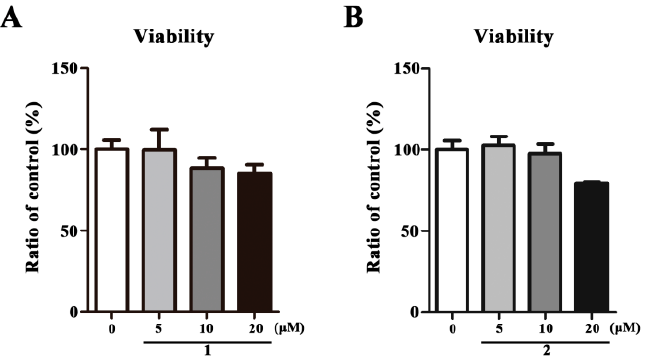
Figure 3. The effect of 1 and 2 on cell viability in HepG2 cells. HepG2 cells were treated with the indicated concentrations of 1 or 2 for 48 h followed by MTT assay. All the data are expressed as mean ± SEM ( n = 3) and analyzed by ANOVA with the Bonferroni’s Test.